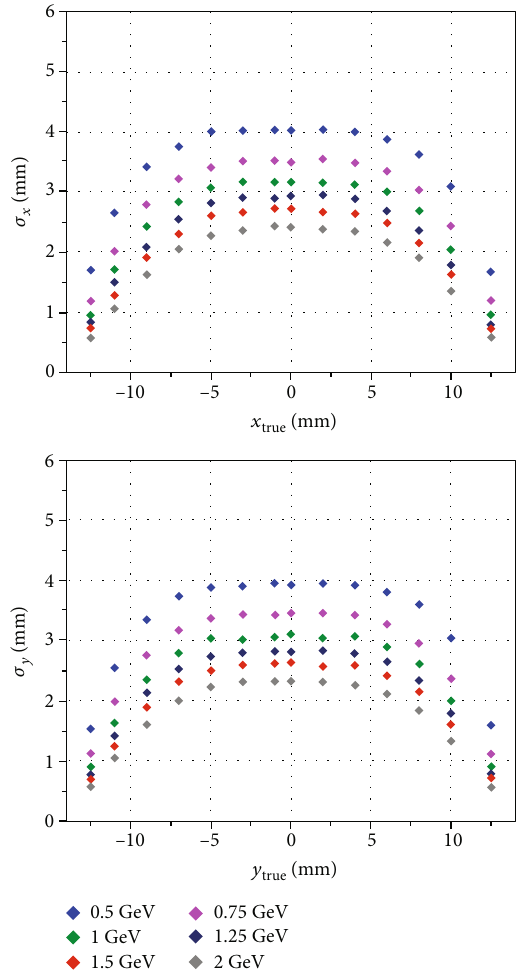
Figure 6: Position resolutions versus the impact position of the electron in the X and Y directions.